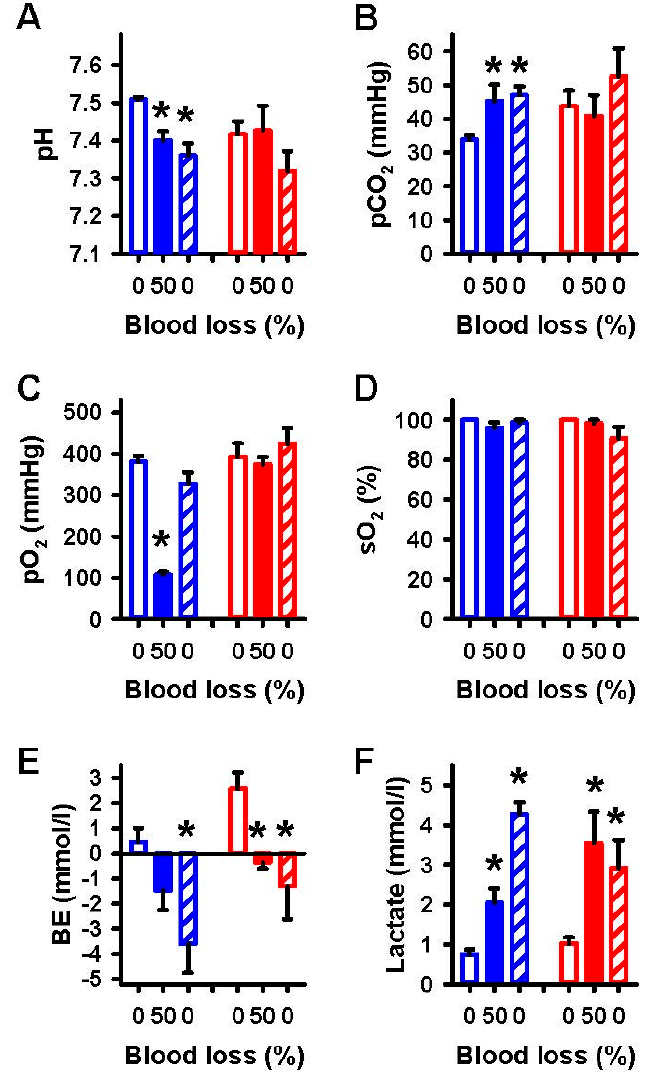
Figure 1. Effects of 50% blood loss and reperfusion on arterial blood gases and lactate. Values are given for baseline (open bars), removal of 50% blood (filled bars) and complete reperfusion (hatched bars) in controls (blue) and after α 1A-adrenergic blockade (red) for ( A ) pH, ( B ) partial pressure of carbon dioxide (pCO 2 ), ( C ) partial pressure of oxygen (pO 2 ), ( D ) oxygen saturation (sO 2 ), ( E ) base excess (BE) and ( F ) lactate. Mean ± SEM; * p < 0.05 compared to baseline.